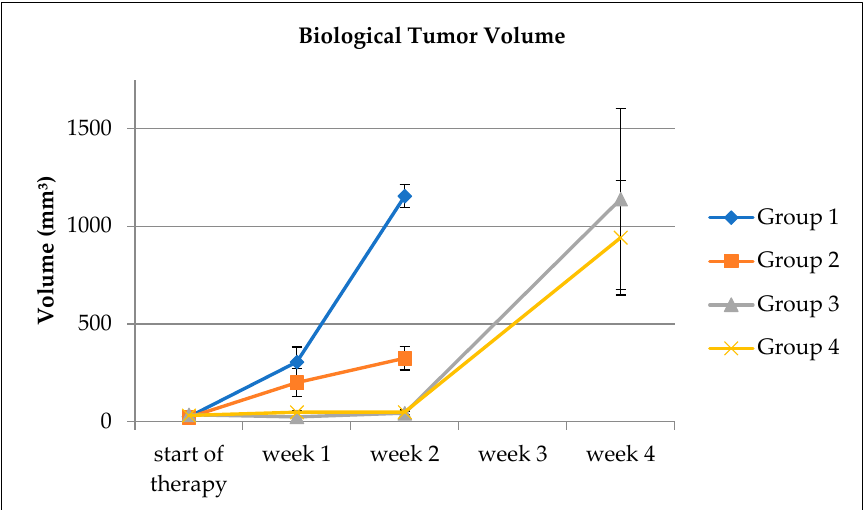
Figure 4. Time course of the tumor volumes determined from the PET scans averaged in the different groups. Error bars indicate the standard error of the mean.